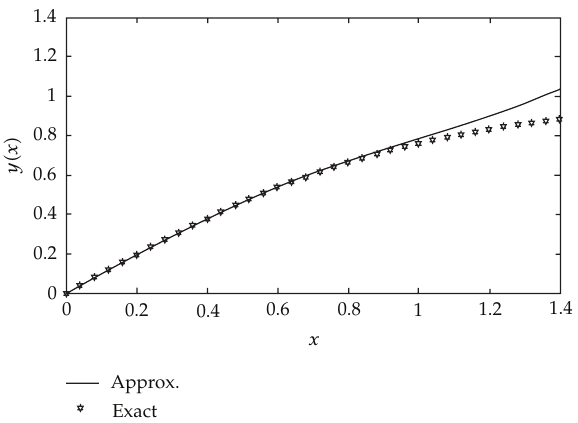
Figure 1: The graph indicates the solution y (cid:3) x (cid:4) for (cid:3) 4.1 (cid:4) , when α (cid:7) 1 .